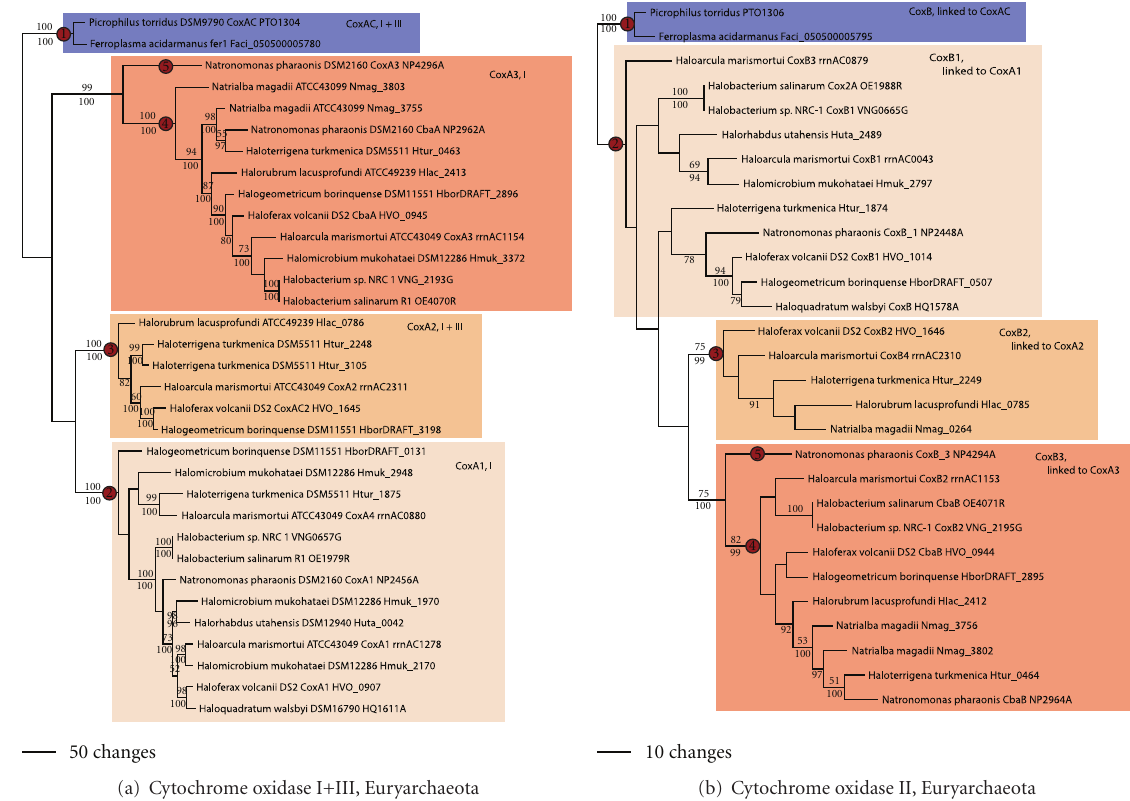
Figure 2: Cytochrome oxidase in the Euryarchaeota. Phylogenetic trees for (a) cytochrome oxidase subunit I and (b) cytochrome oxidase subunit II. Putative lateral transfer events are indicated using a filled red circle. The locus tag numbers are provided for taxa with genome sequences (accession numbers are provided for taxa without genome sequences). Trees shown have branch lengths and relationships constructed using the maximum parsimony method. Bootstrap values above 50% from the maximum parsimony method are shown above each branch, and branches without values had less than 50% support. Posterior probabilities from the Bayesian method are shown below each branch. Major archaeal clades are indicated using colored boxes, and potential lateral gene transfer events are identified at the base of the node for these clades with a filled red circle. Nodes discussed in the text were assigned sequential circled